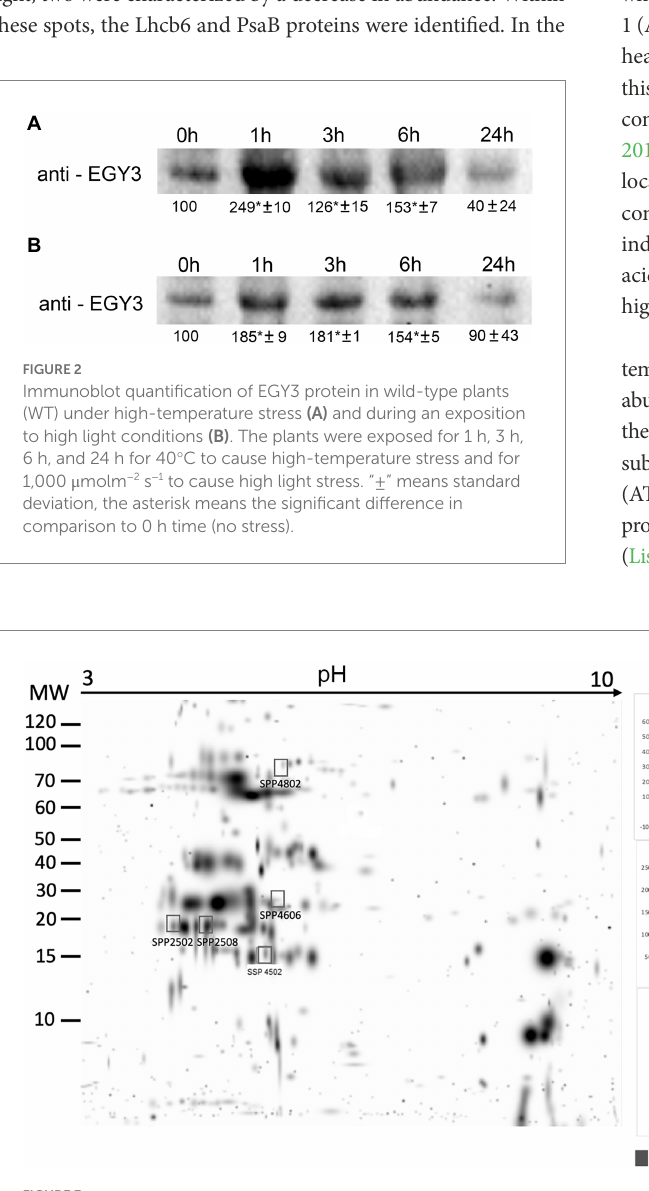
FIGURE 3 Two-dimensional electrophoresis gels of thylakoid membrane proteins isolated from wild-type (WT) and egy3-1 and egy3-2 lines, exposed to 3 h of high light conditions. Proteins were separated using 2-D gel electrophoresis with IEF (pH 3–10) and detected with Coomassie Brilliant Blue staining. The image is digitally generated using the PDQuest Advanced 2-D Gel Analysis Software, (Bio-Rad, Hercules, United States) master gel, based on four electrophoretic separations made for two independent biological repetitions. The protein accumulation in the bar graphs was expressed in arbitrary